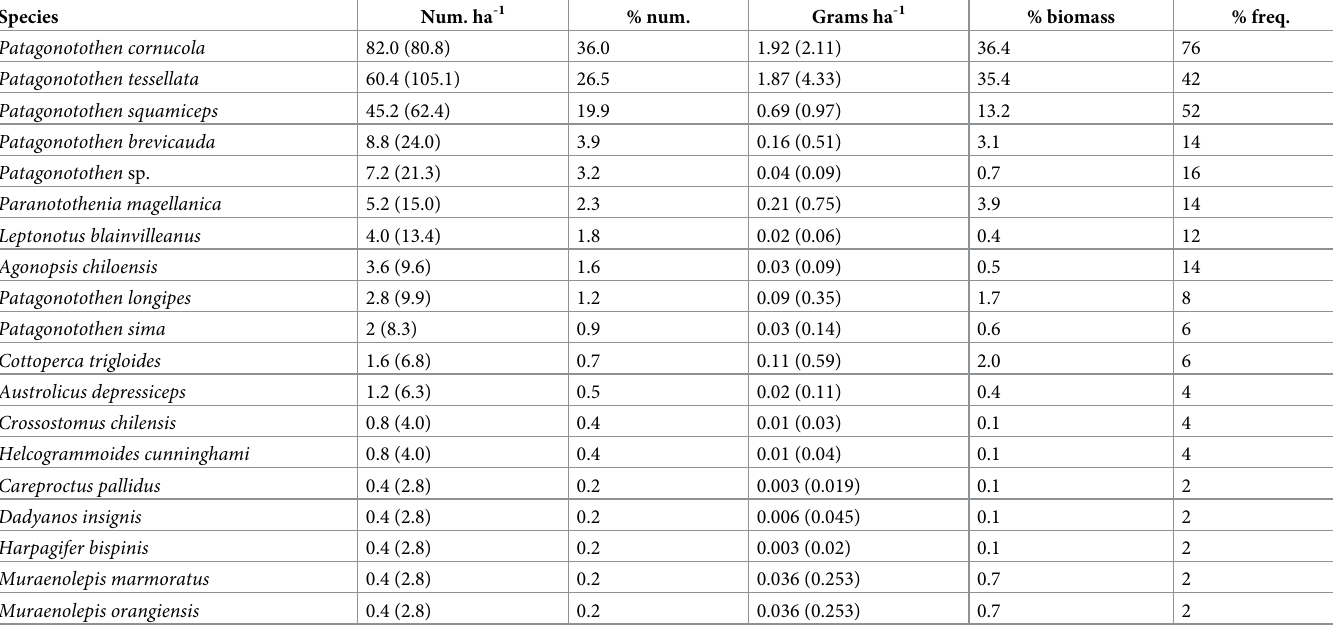
Table 3. Summary statistics for shallow-water fish species observed on quantitative transects.